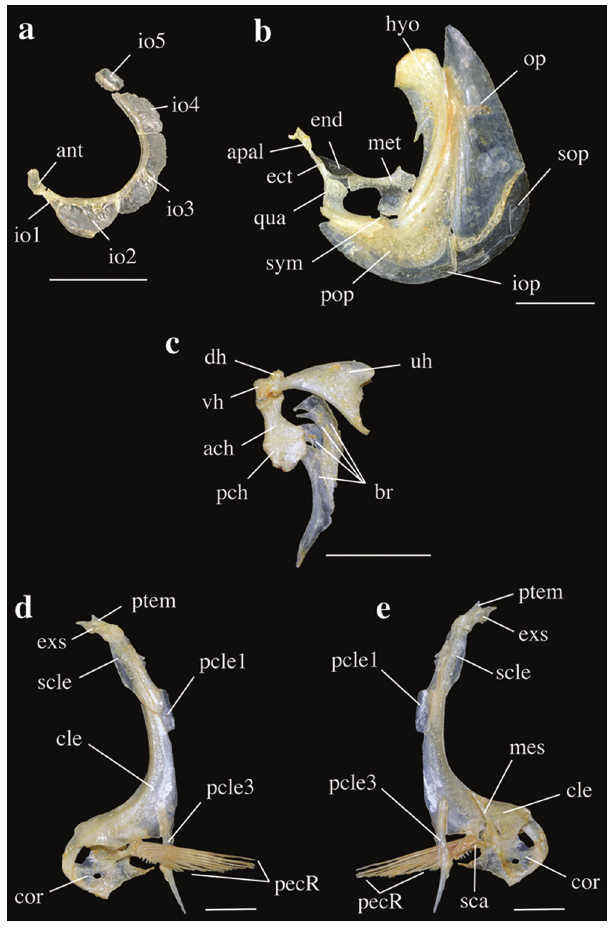
Fig. 5: Osteology of Metynnis melanogrammus , INPA 18457, 144.8 mm SL: a . hyopalatine and opercular series; b, infraorbitals; c. hyoid arch; d. left pectoral girdle, lateral view;